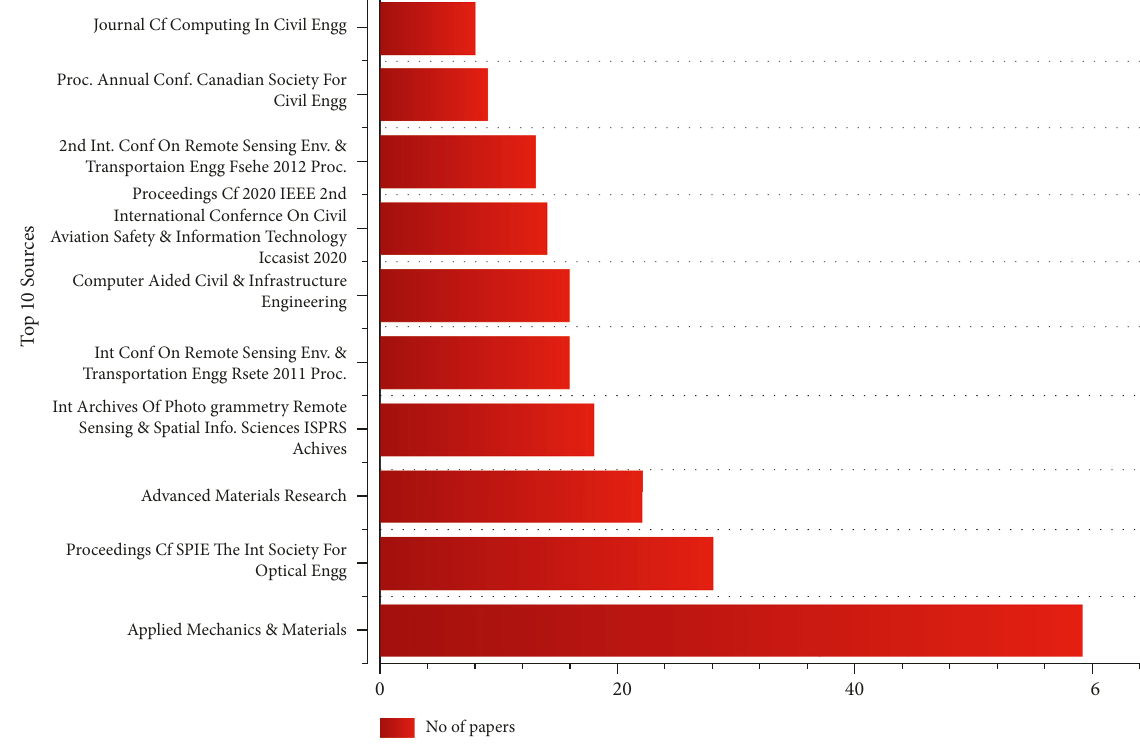
Figure 11: Top 10 sources for 2001 to